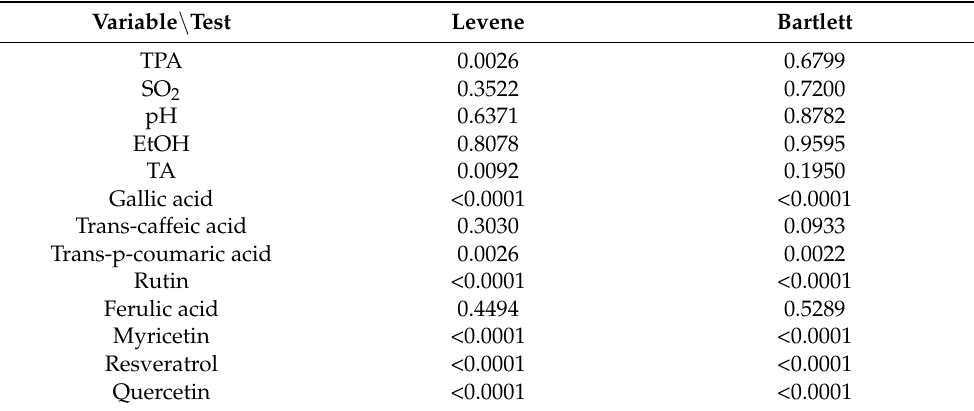
Table 3. Statistical evaluation of oenological parameters and biologically active